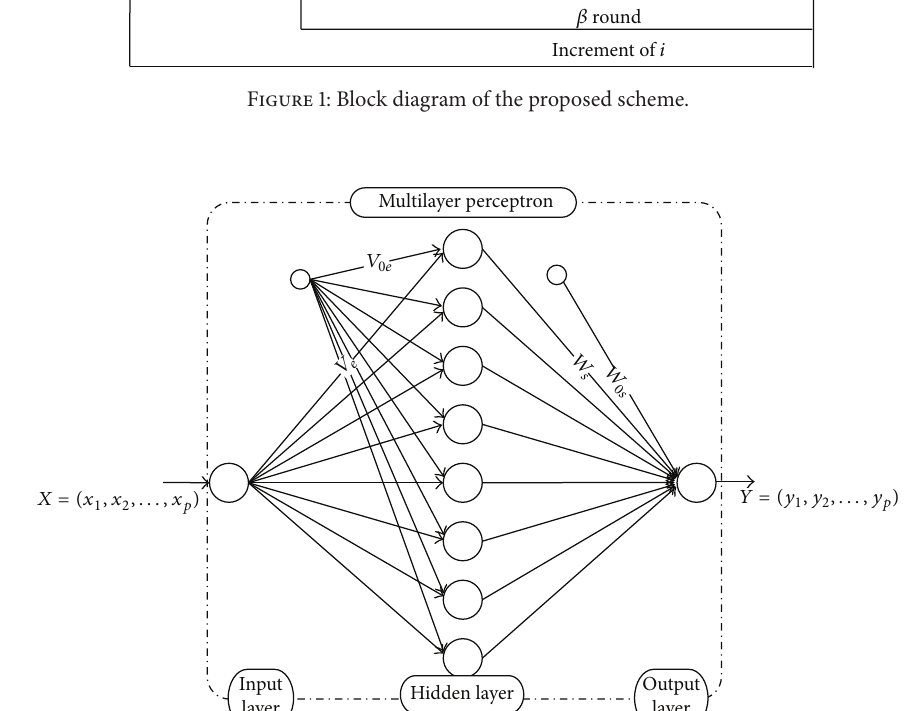
Figure 2: Multilayer perceptron